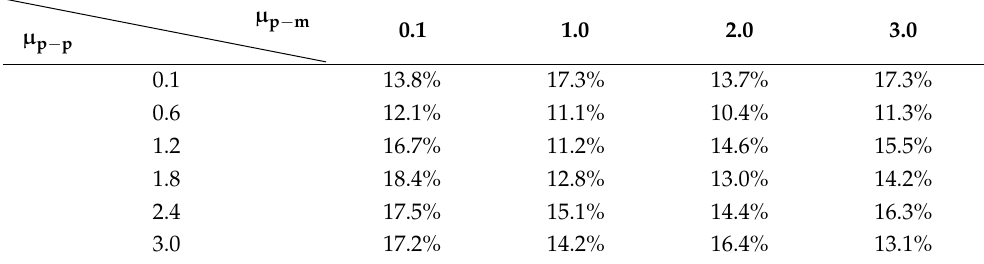
Table 4. Proportion of the number of contacts between the lignin particles and membranes to the total. µ 𝛍 p − 𝐩(cid:2879)𝐦